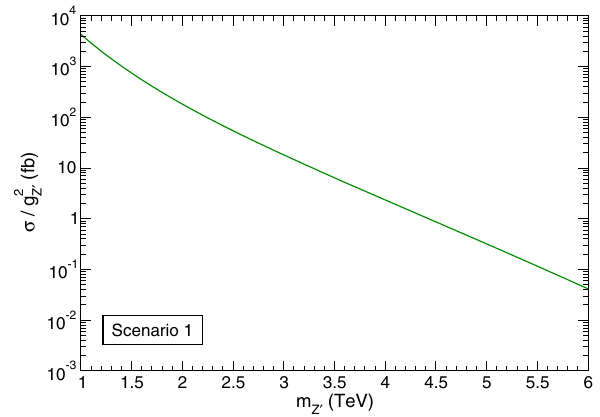
Fig. 1 Z (cid:2) production cross section in scenario 1 of Ref. [7]